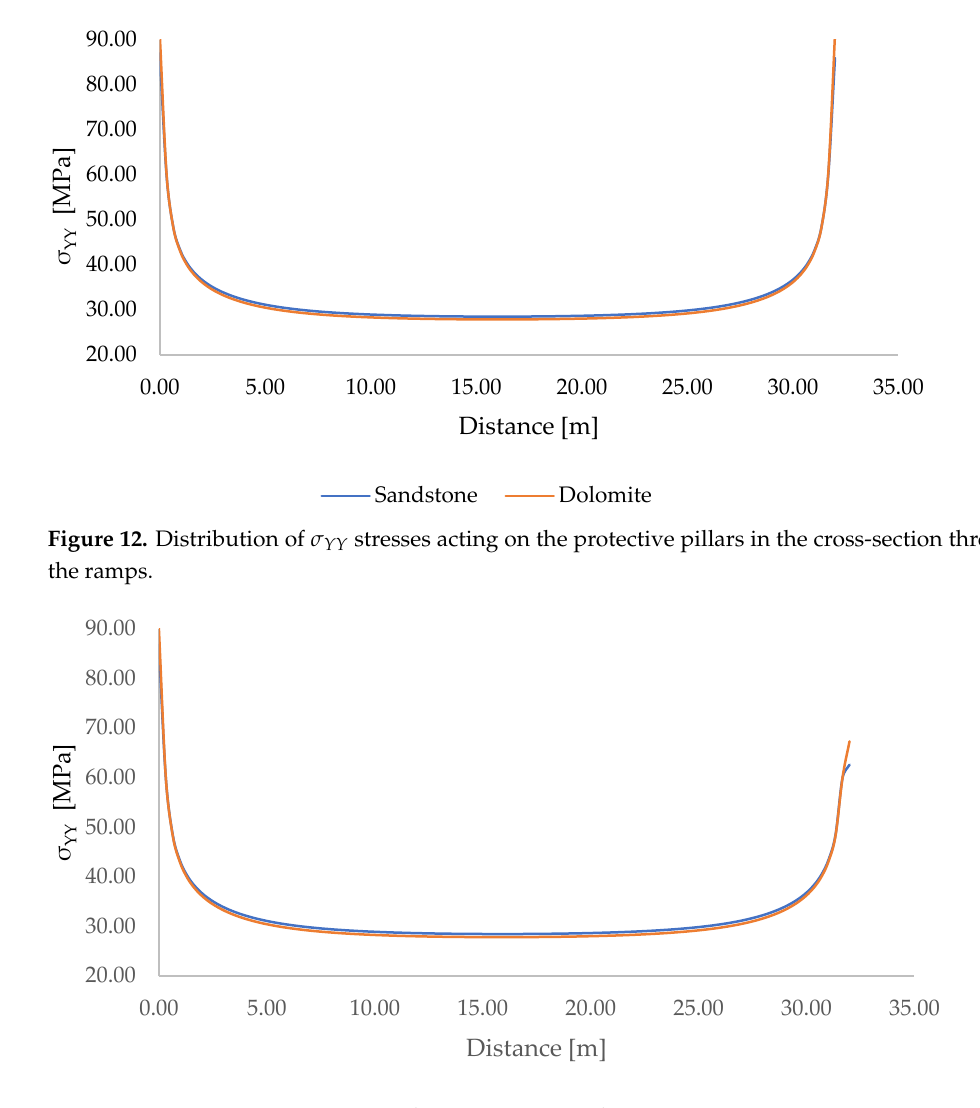
Figure 11. Stress measurement location used to create a graph presenting the distribution of stress acting on protective pillars in the cross-section through: ( a ) ramps; ( b ) entries.